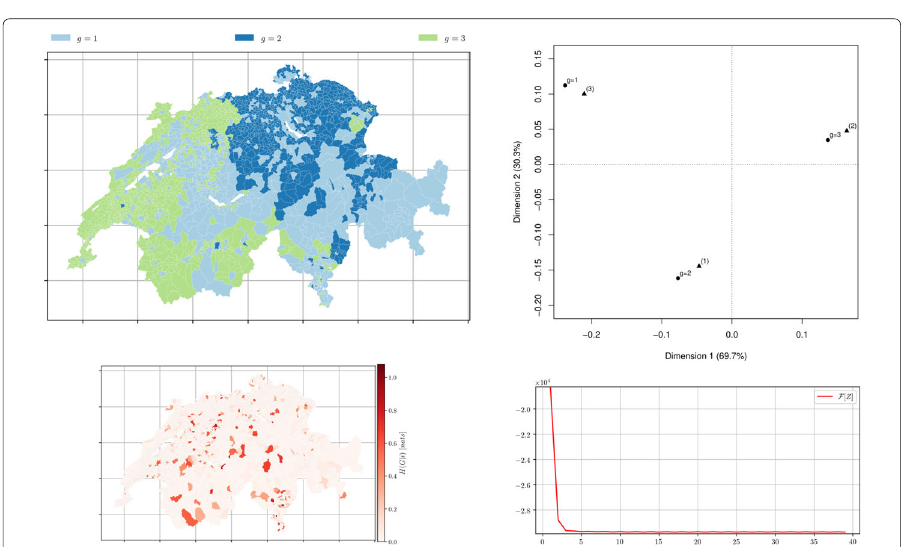
Fig. 10 Municipalitiessoftclusteringonallthetopics depicts the semi-supervised hard assignment obtained from a official classification Z 0 for m = 3 groups using distance matrix D obtained from topic modelling with k = 3 after 39 iterations. Lefttop Hard membership. Leftbottom the conditional entropy of topics H ( R | i ) showing municipality-topic probability distribution uncertainty. Righttop the correspondence analysis between Z ∞ ( • ) and the official classification ( (cid:2) ) with m = 3. Rightbottom The free-energy plot ( β = 10, α =